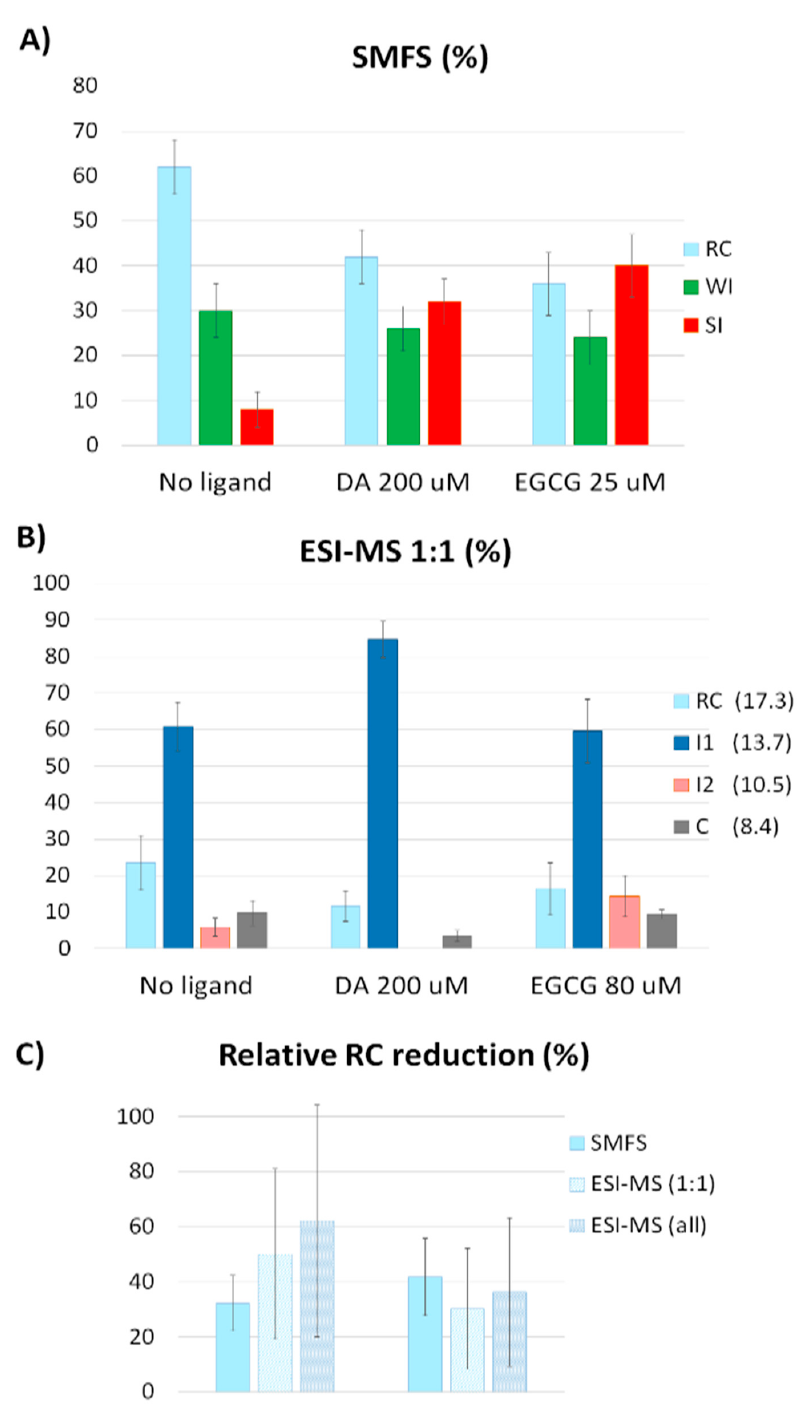
Figure 2. Species distributions as obtained by ( A ) SMFS and ( B ) native MS. The intensity-weighted average charge of the peak envelopes is reported in brackets (i.e., RC = 17.3; I1 = 13.7; I2 = 10.5; C = 8.4). Error bars in panel (A) represent the standard deviation calculated for the normal distribution. Error bars in panel (B) represent the standard deviations from three independent experiments. ( C ) RC reduction in response to ligand binding, relative to the free protein, as obtained by SMFS and native MS, considering the 1:1 protein:ligand complexes (1:1) or the cumulative MS data (all). Error bars in panel (C) represent the propagated standard deviation.